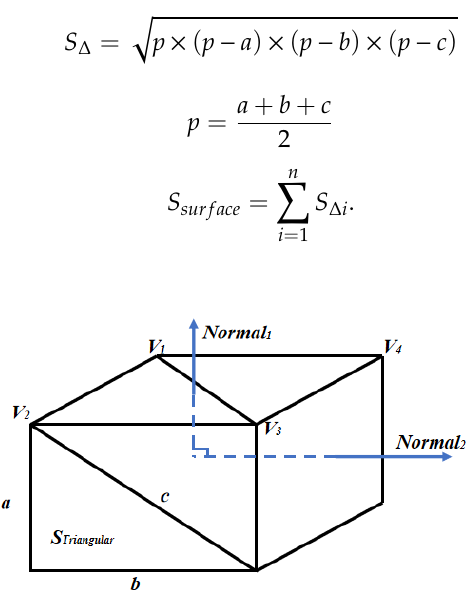
Figure 8. Triangular surface construction of the 3D model.